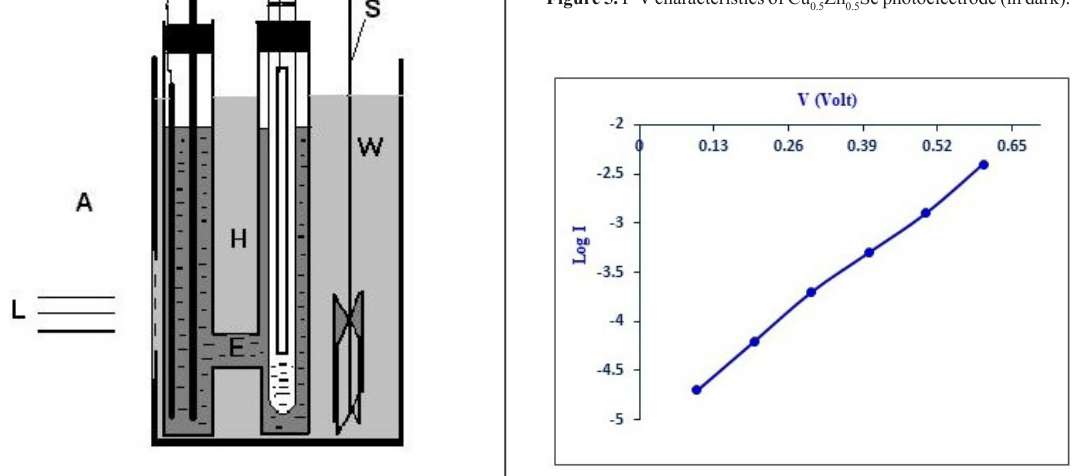
Figure 5. I–V characteristics of Cu